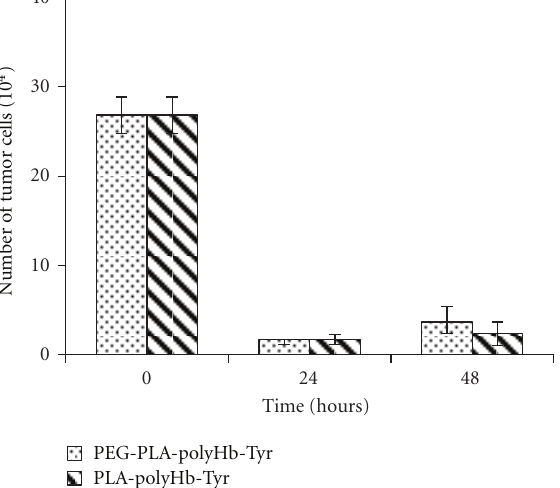
Figure 10: The functions of PEG-PLA and PLA nanocapsules on the attachment of B16F10 melanoma